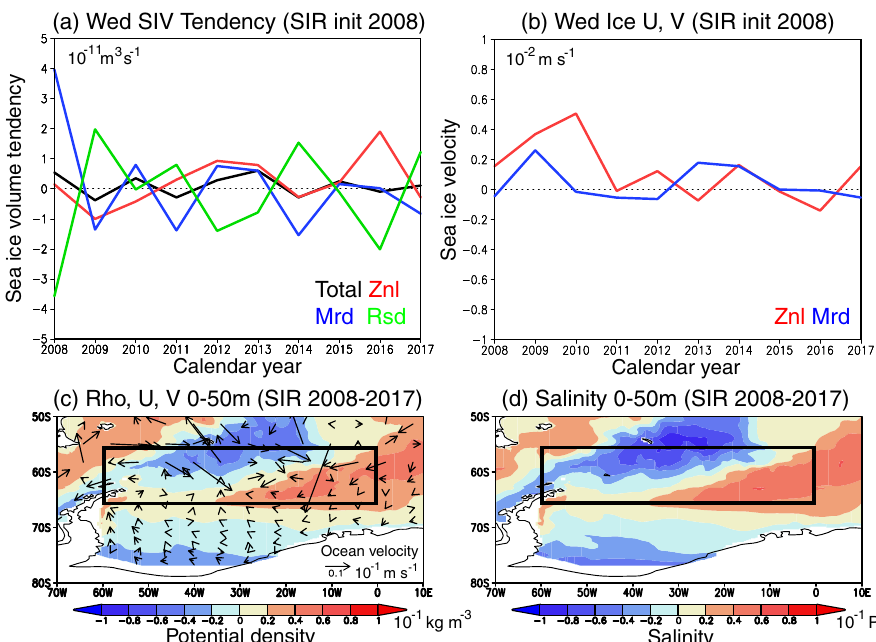
Fig. 7 Sea ice volume (SIV) tendency anomalies and near-surface ocean conditions in the Weddell (Wed) Sea. a Time series of sea ice volume (SIV) tendency anomalies (Total; black in 10 − 11 m 3 s − 1 ) and its zonal (Znl; red), meridional (Mrd; blue) and residual (Rsd; green) components (see Eq. (1) in Methods) in the Weddell (Wed; 60° − 0°W, 65° − 55°S) Sea for the SIR experiment predicted from March 1st 2008. We calculated the anomalies with respect to the period of 1982 – 2018. b Same as in a , but for sea ice zonal and meridional current velocity (Ice U and V; in 10 − 2 m s − 1 ) anomalies in the Wed region. c 10-yr mean of the upper 50-m potential density, zonal and meridional current velocity anomalies predicted from March 1st 2008 in the SIR experiment. A black box indicates the Wed region. d Same as in c , but for the upper 50-m ocean salinity (S; in 10 − 1 PSU)